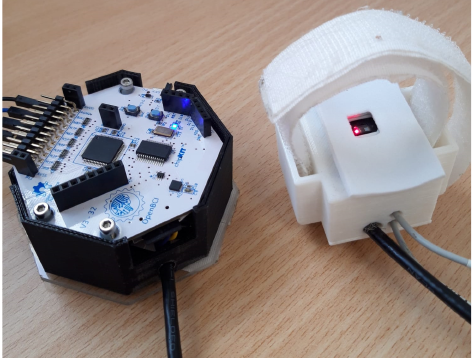
Figure 5. Black case in which the OpenBCI board is attached with screws and just below the board there are the power supply for the system (9 V battery) and the Atmega328p microcontroller. On the lower part of the case there are two Velcro strips so that it can be placed on a strap around the user’s waist.